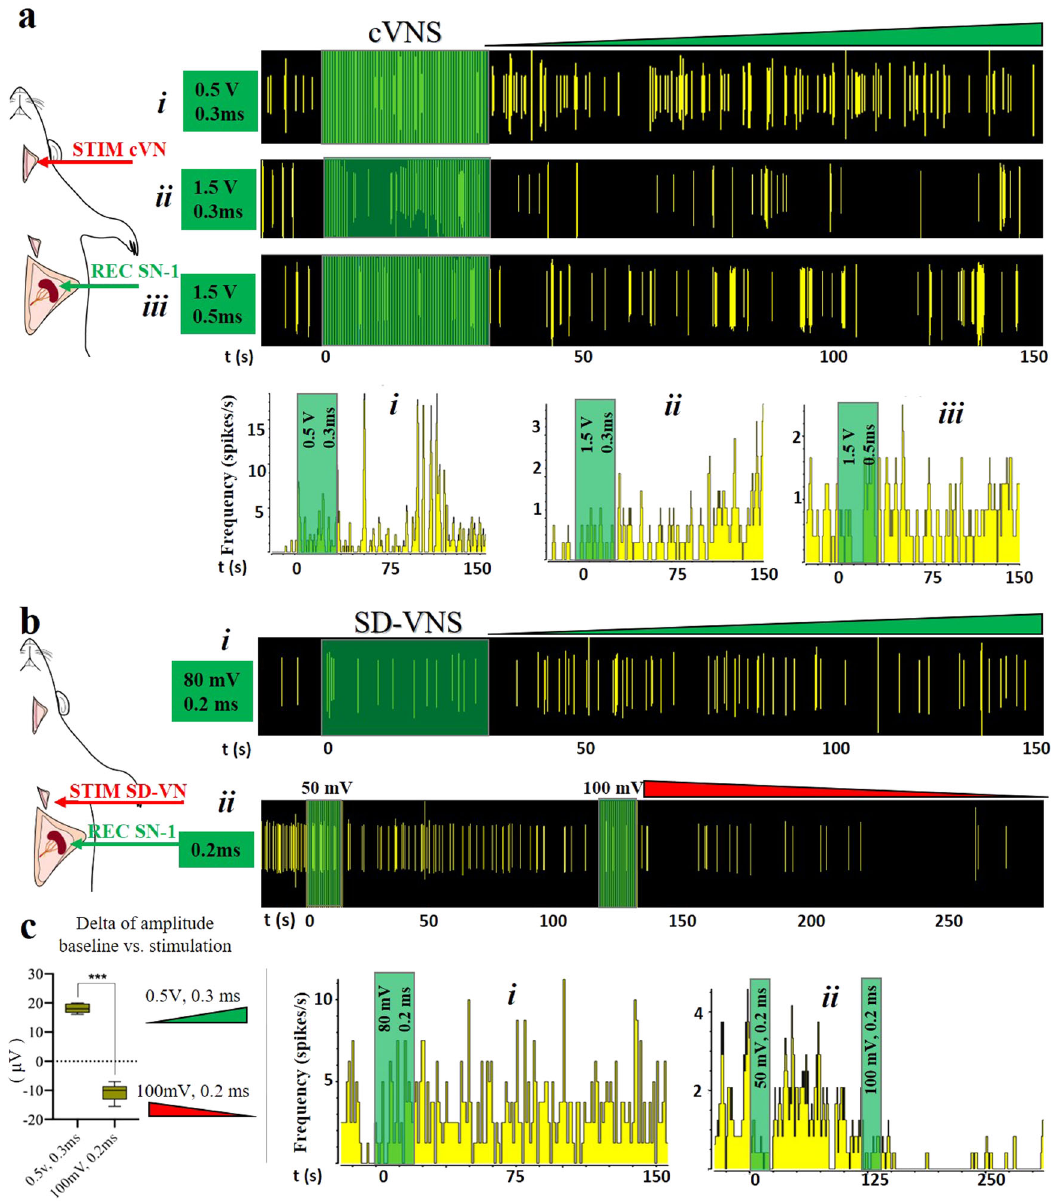
Fig. 7 Inhibition of apical branch activity by cVNS. a The activity in SN-1 after cVNS increased at (i) 0.5 V. (ii) At 1.5 V cVNS caused the opposite effect. (iii) Increasing the pulse to 0.5 ms, at 1.5 V had an intermediate effect. b SD-VNS with: (i) 0.2 ms stimulation at 80 mV caused an increase in activity, whereas stimulation of 50 and 100 mV (ii), inhibited SN-1 spontaneous activity. Green and red triangles indicate an increase and decrease in activity, respectively. Rate histograms are presented for each raster plot, representative waveforms are plotted, bin = 1 s. c Delta of changes on the amplitude of the signal (baseline vs. stimulation at 200 s) means± standard deviation are: increase on 18.16 ± 1.6 and decrease on − 10.68 ± 3.07 μ V for 0.5 V, 0.3 ms and 100 mV, 0.2 ms, respectively. T test análisis, p < 0.0001 ( n = 3 rats, 3 – 5 repetitions each). cVNS cervical vagus nerve stimulation, SD-VNS subdiaphragmatic vagus nerve stimulation, SN splenic